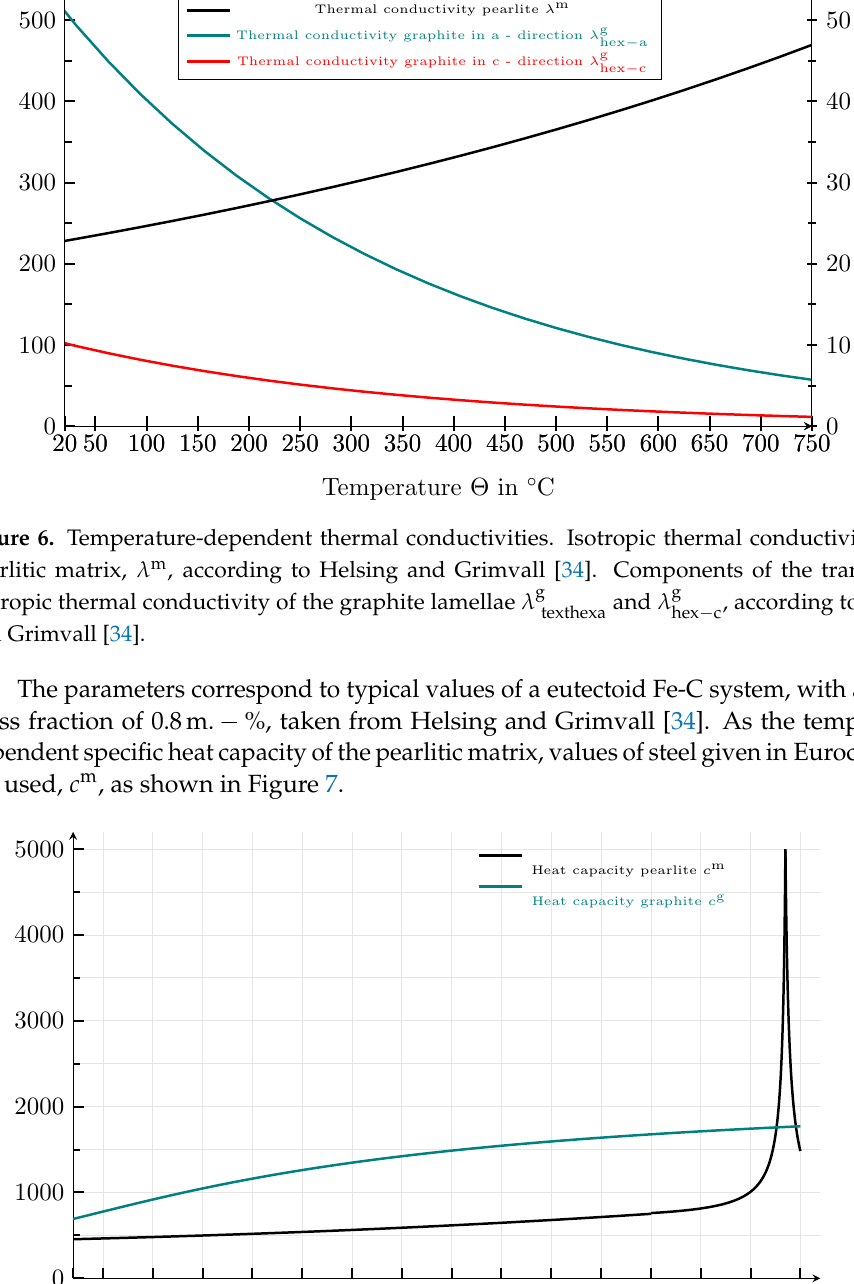
Figure 7. Temperature-dependent heat capacities of the pearlitic matrix [31] and the graphite lamel- lae